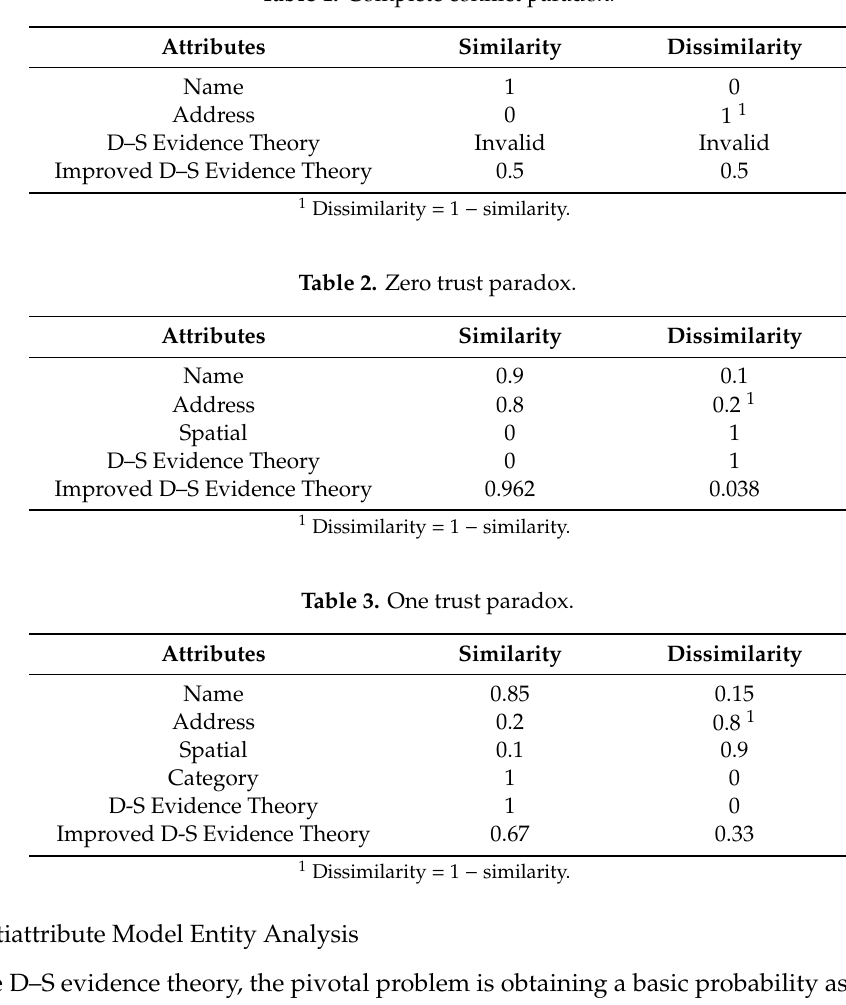
Table 1. Complete conflict paradox.